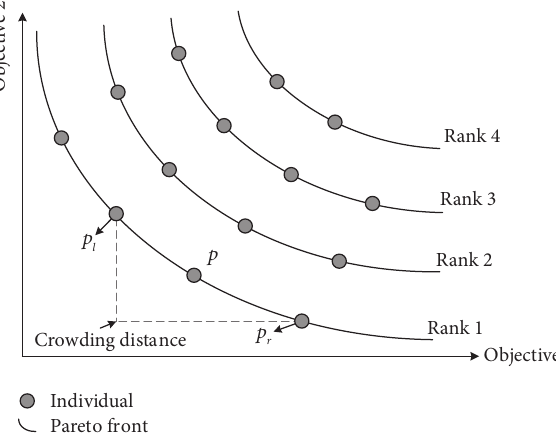
Figure 5: Calculation of crowding distances of